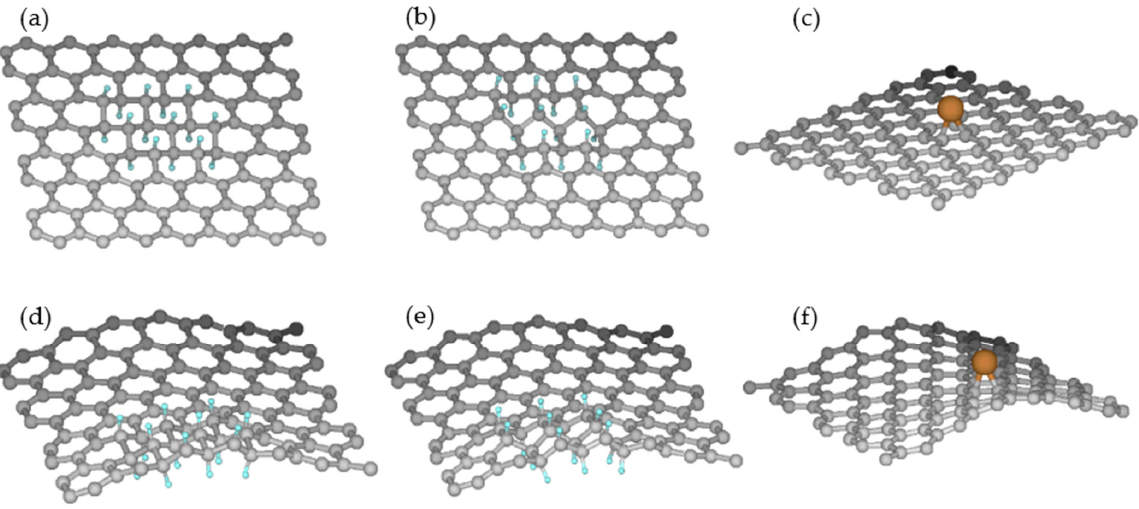
Figure 7. Planar and rippled graphene sheets for hydrogenation and copper binding. ( a ) Chair-like hydrogenation on